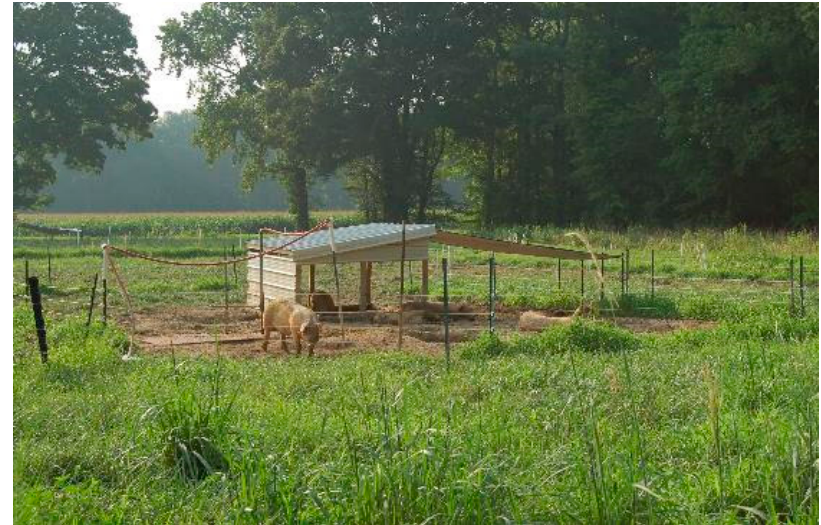
Figure 6. View of the service-central area of a rotationally managed paddock. The portable shelter, the tarp used to provide additional shade and the drinking structure with a hose and two nipple drinkers can be seen. Two walls of the shelter were removed to allow for extra ventilation during summer.